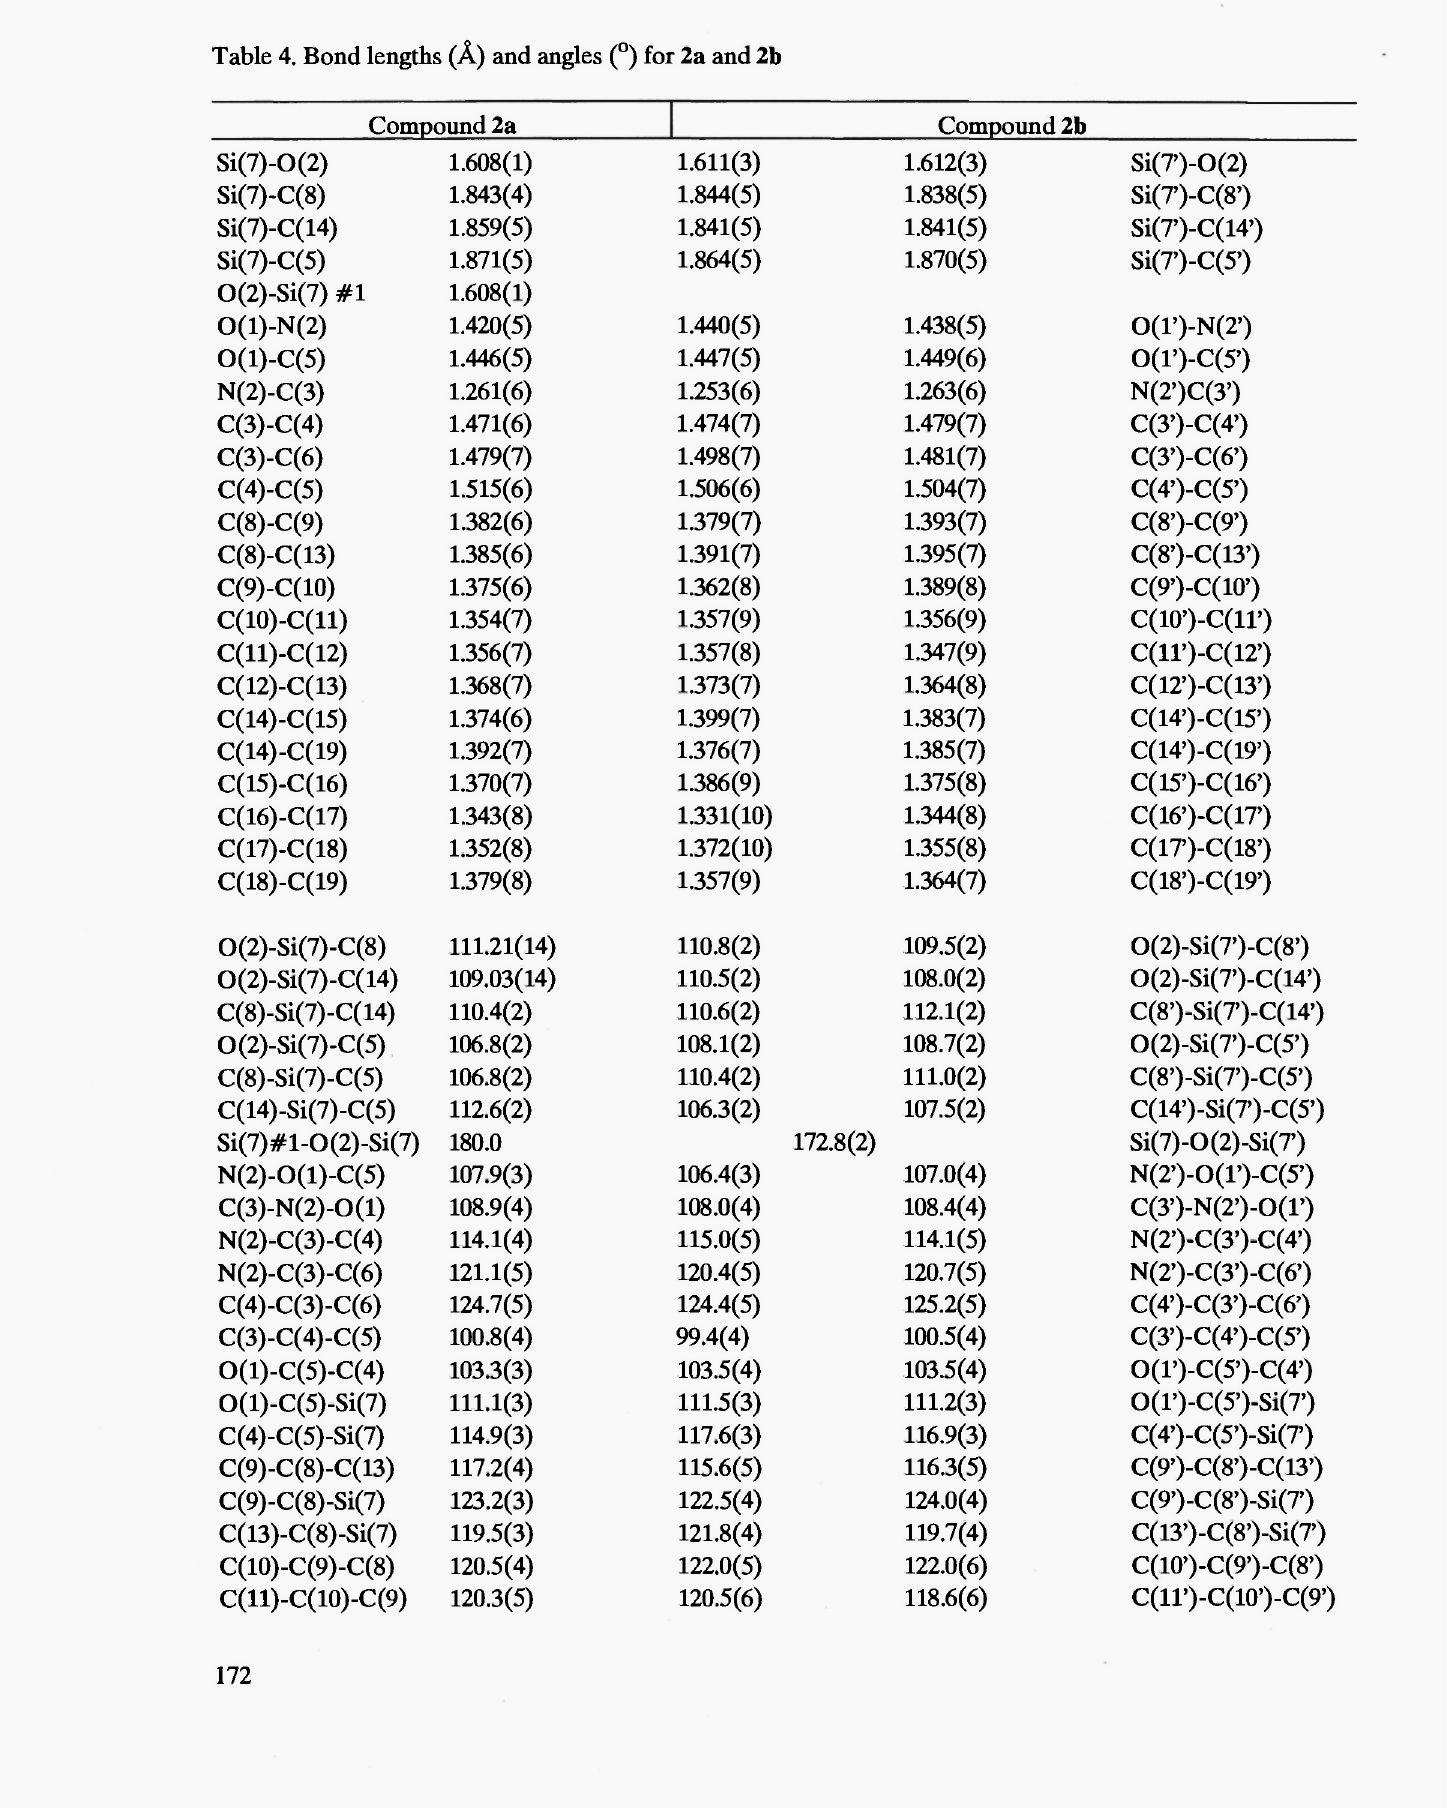
Table 4. Bond lengths (Ä) and angles (°) for 2a and